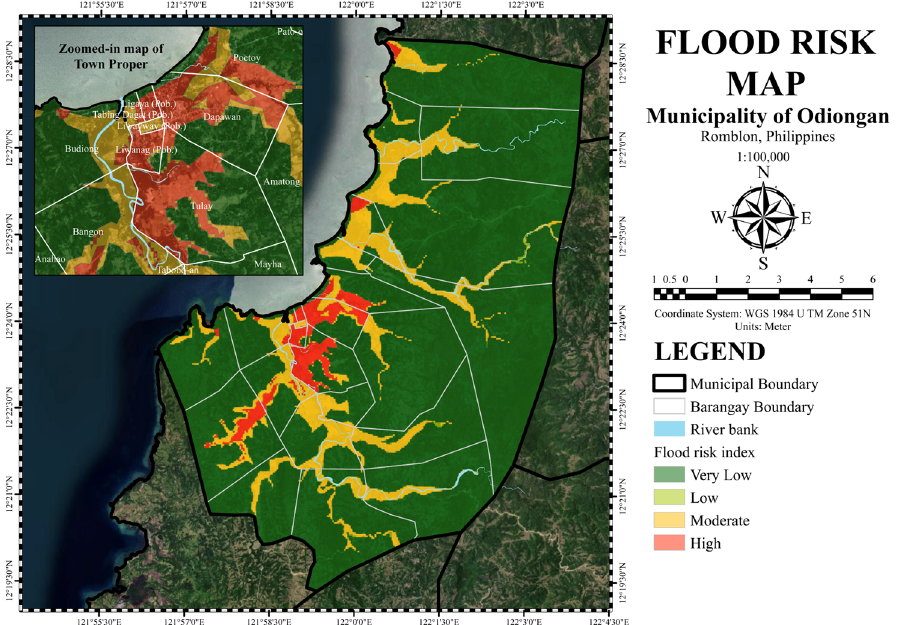
Figure 11. Imagery and flood risk map (50% transparency) with 1:50,000 scale zoomed-in map of town proper of the Municipality of Odiongan.